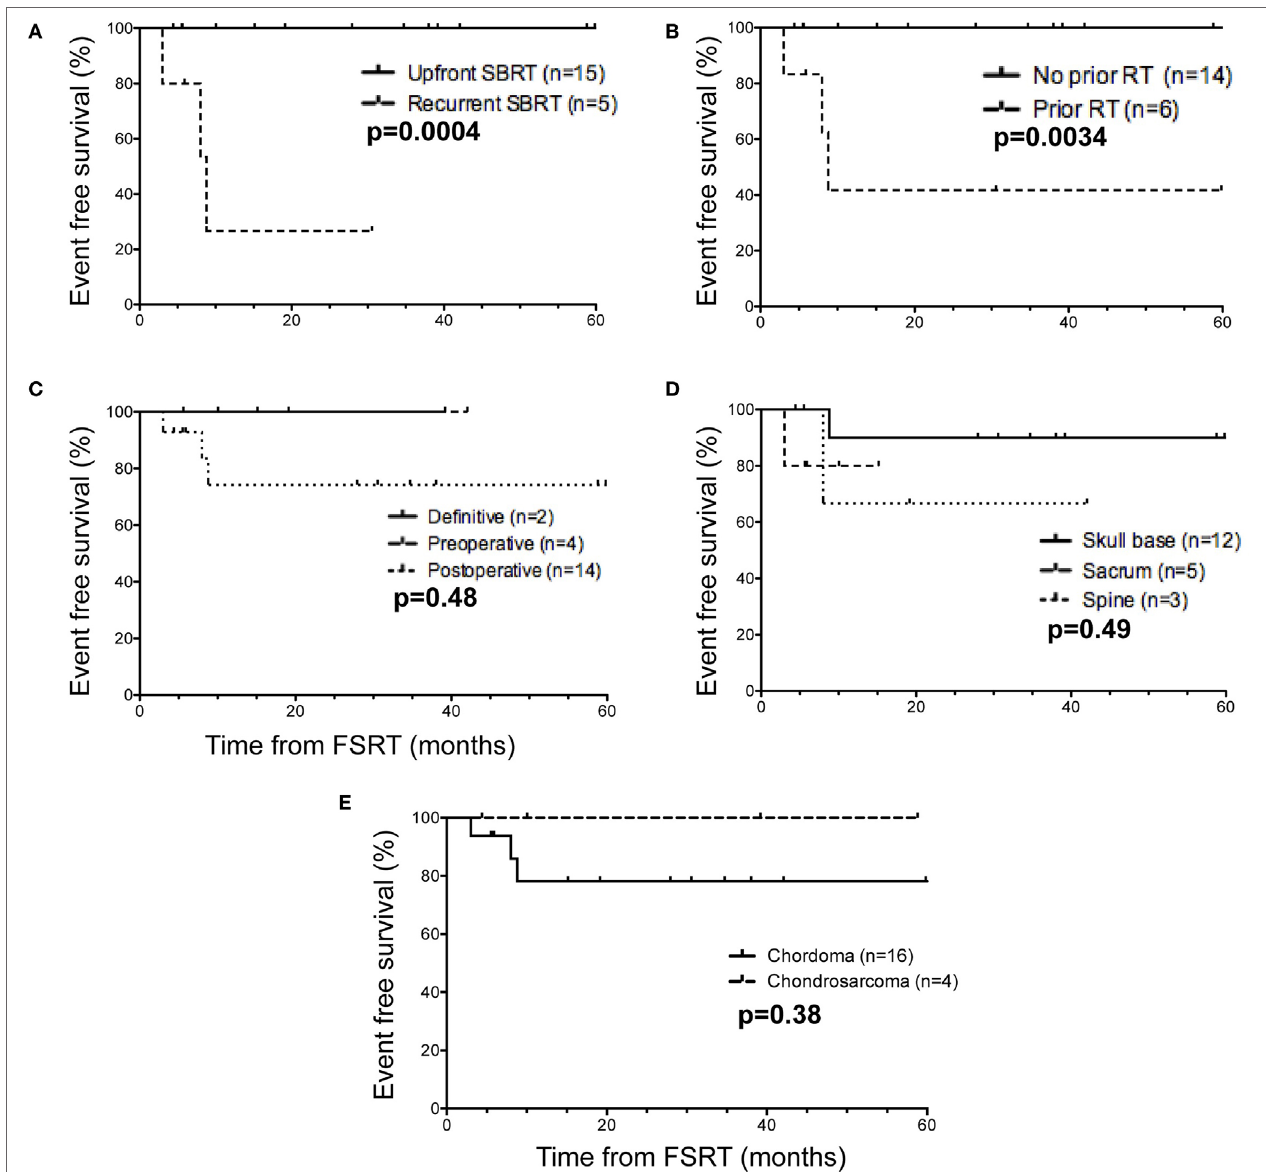
FigUre 2 | Event-free survival in selected patient subgroups relative to time of fractionated stereotactic radiotherapy (FSRT). (a) When separating FSRT in the upfront (solid line) versus recurrent (dashed line) setting, a minority of patients ( n = 5) received FSRT for recurrent disease, and this group encompassed all patients with significant events (3/5). (b) Considering prior history of radiation therapy (protons or EBRT) ( n = 6), all patients with reported events (3/6) received radiation therapy before undergoing FSRT. (c) With respect to definitive (solid line) versus preoperative (dashed line) versus postoperative FSRT (dotted line), the majority of patients ( n = 14) received FSRT in the postoperative setting, including all patients with significant events (4/14). (D) Based on anatomic site of the tumor, one local recurrence was in a sacral tumor (dashed line), and the second recurrence was in a tumor in the cervical spine (dotted line). For skull base tumors (black), one death but no local recurrences were observed. (e) With regard to histological subtype, the majority of patients were diagnosed with chordoma ( n = 16, black line) compared to chondrosarcoma ( n = 4, dashed), and all three events occurred in chordoma patients. Significant events were defined as tumor recurrence (local, regional, or distant) or death, and reported p -values are from the log-rank (Mantel–Cox)